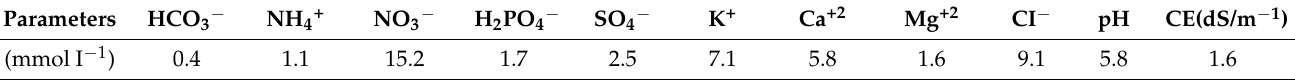
Table 2. Applied nutrient